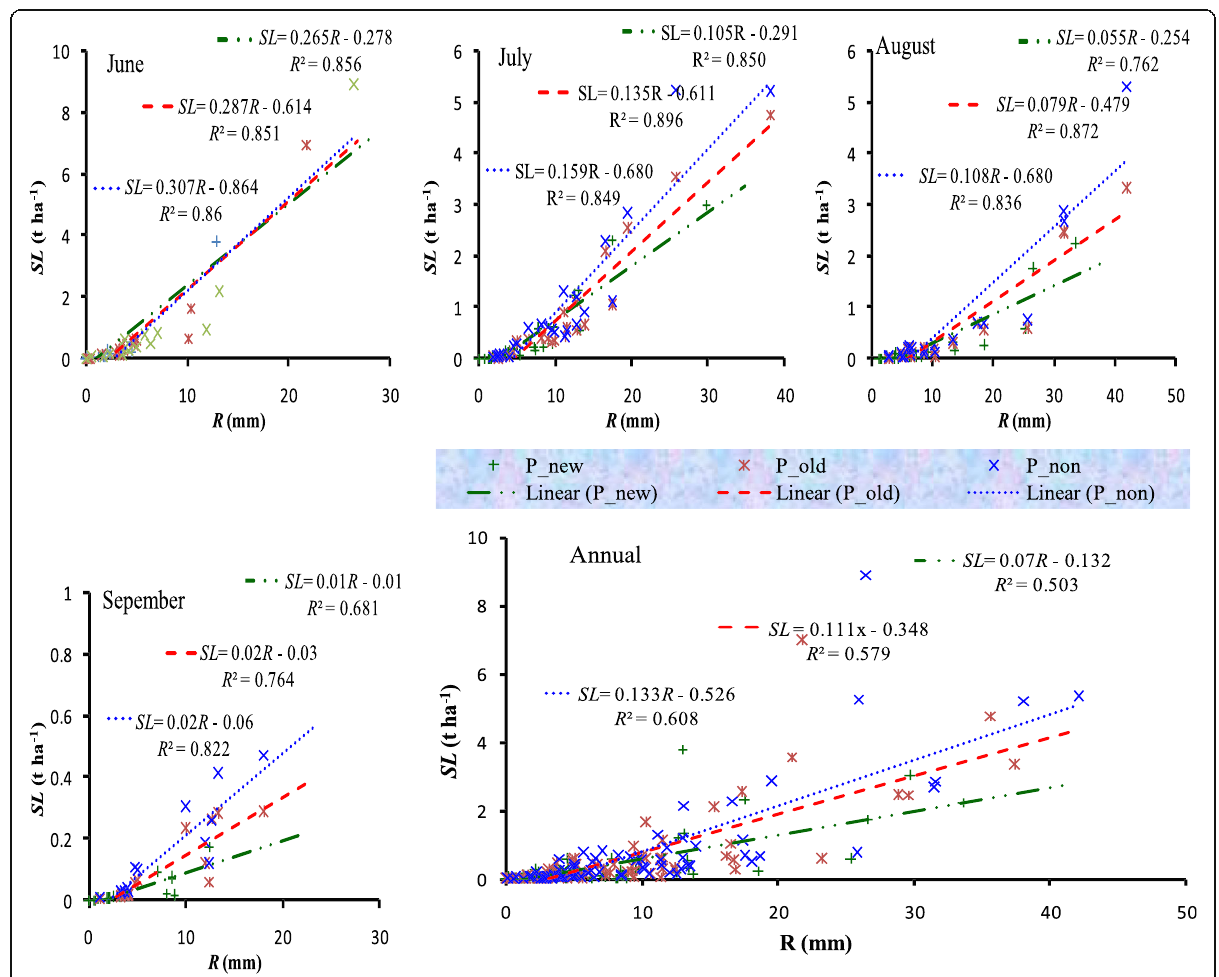
Fig. 8 Runoff-soil loss relationship within plots treated with new soil bund, old soil bund, and